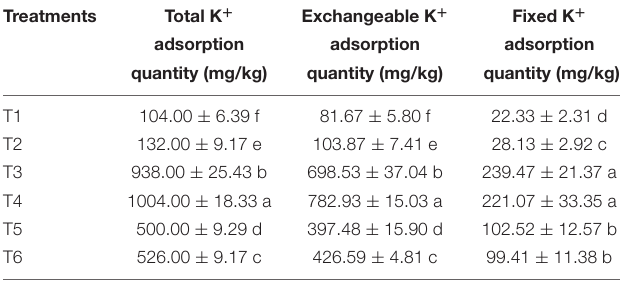
FIGURE 5 | Relationships between the concentrations of KH 2 PO 4 solution added and the total P adsorption quantity. T1, sand; T2, sand + 1% HA; T3, cocopeat; T4, cocopeat + 1% HA; T5, 1:1 sand: cocopeat; T6, 1:1 sand: cocopeat + 1% HA. TABLE 6 | Effects of 1% HA addition on phosphorus storage capacity of different substrates.